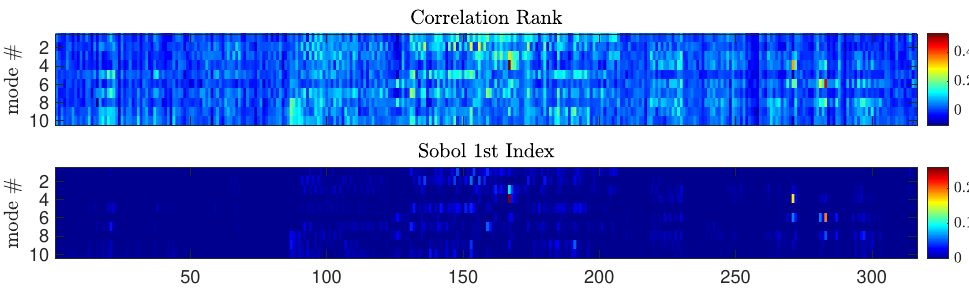
Figure 12. Dam-2; comparison of sensitivity indices for two methods and 10